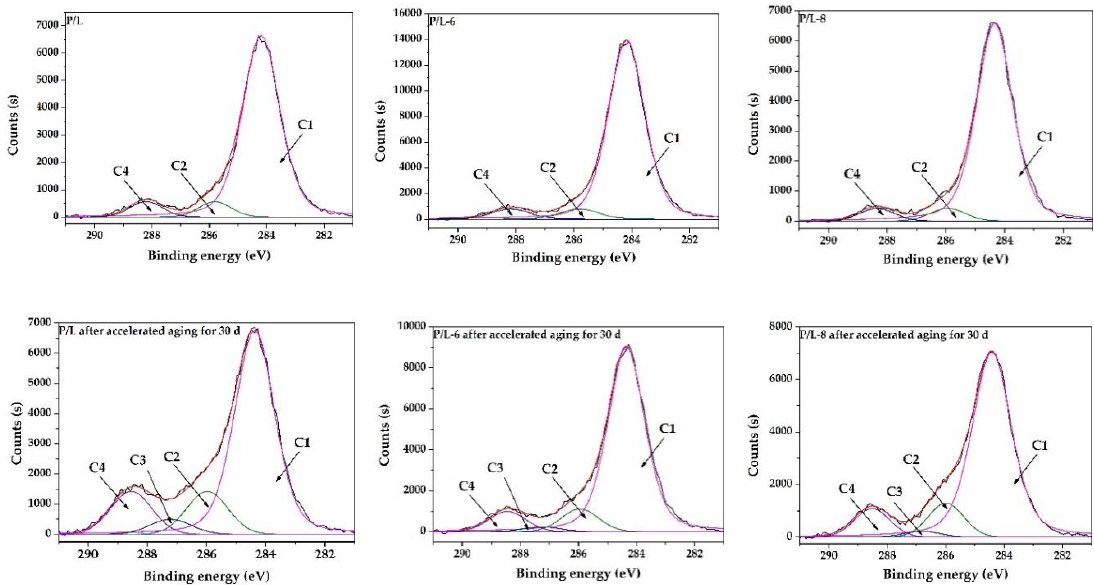
Figure 7. High-resolution XPS spectra of samples before and after accelerated aging. Table 3. Surface chemistry components of SLS parts as determined by